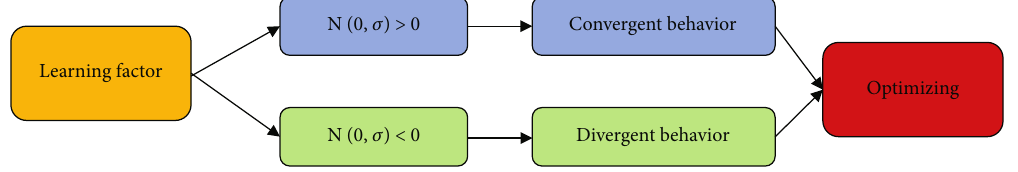
Figure 4: Individual learning